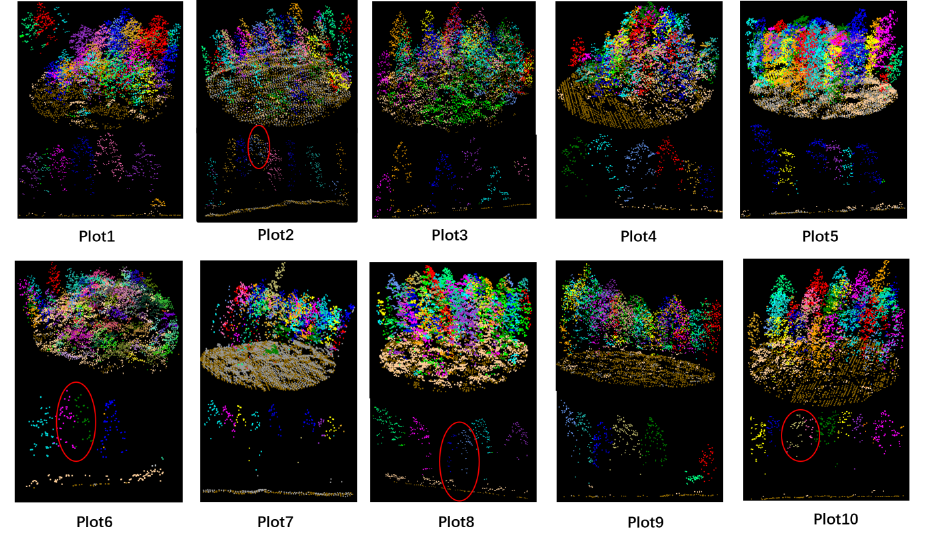
Figure 17. Single tree segmentation results of ten plots. Table 4. the shape and parameters of the tree samples. Table 4. The shape and parameters of the tree samples.